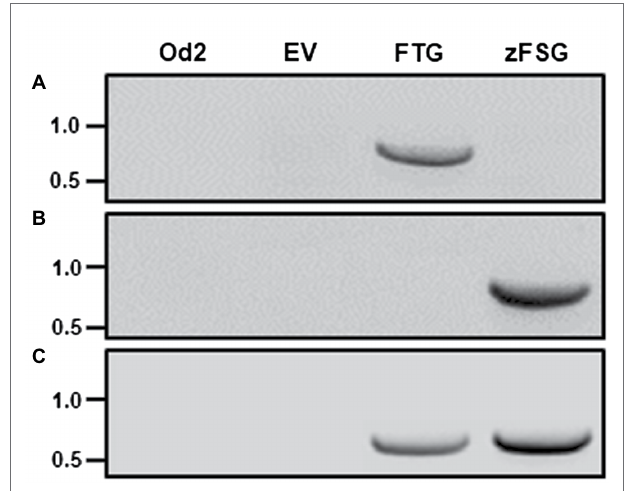
FIGURE 2 | Transient expression of the multicistronic constructs in tomato leaves. Leaves of the tomato odorless-2 mutant were infiltrated with Agrobacterium carrying the pC5-FTG construct, the pC5-zFSG construct, or the empty pMCS vector (EV). Transcript levels in Agrobacterium infiltrated leaves and odorless-2 control (Od2) leaves were analyzed by RT-PCR utilizing AtFPPS (A) , ShzFPPS (B) , and eGFP (C) specific primer pairs (see Figure 1 for location). The amplification products indicating AtFPPS (788 bp), ShzFPPS (794 bp), and eGFP (656 bp) expression were separated by agarose gel electrophoresis (size marker in kb indicated with each